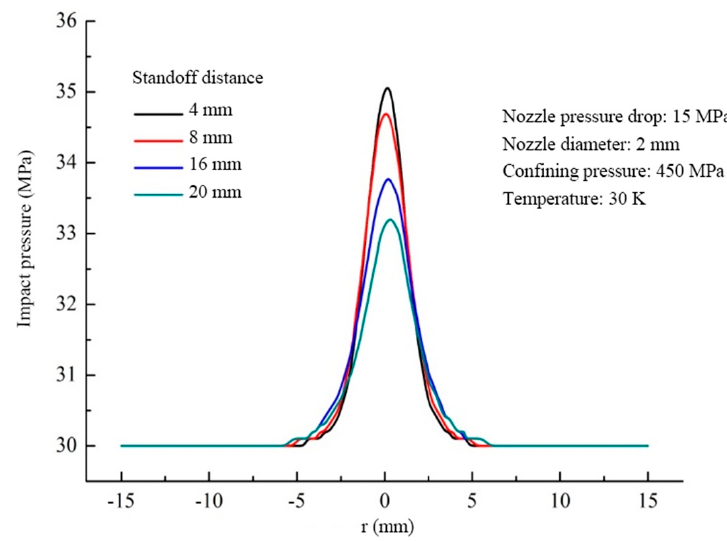
Figure 11. Influence of jetting distance on impact